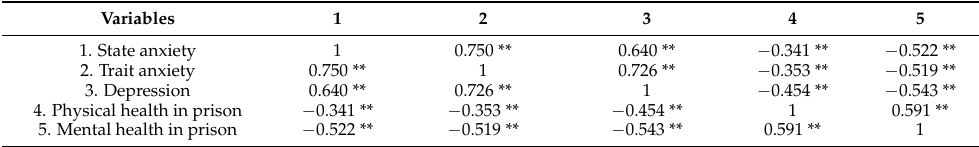
Table 8. Correlation analysis.